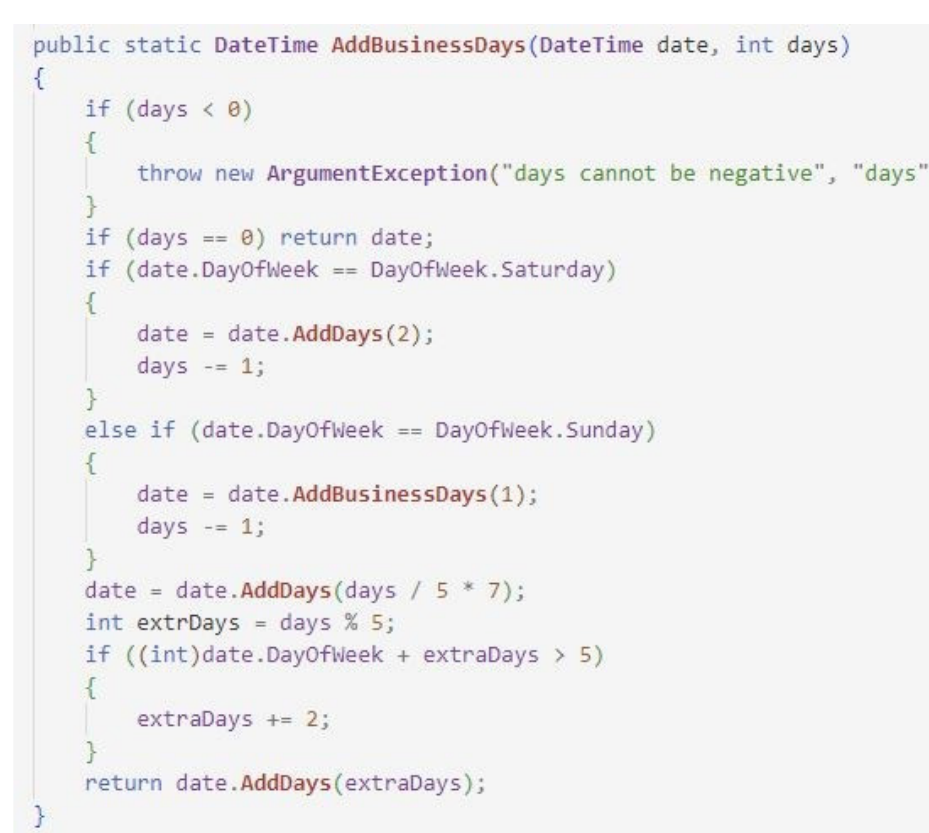
Figure 8. Pseudocode for calculating the number of working days.